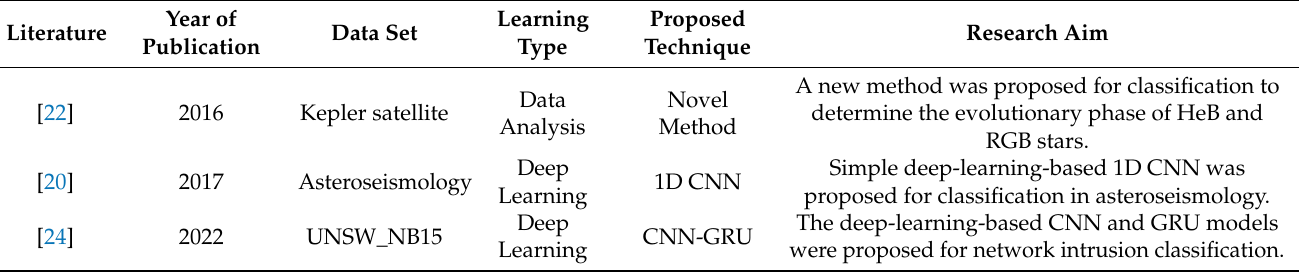
Table 1. The literature summary and comparative analysis with other state-of-the-art studies with our proposed